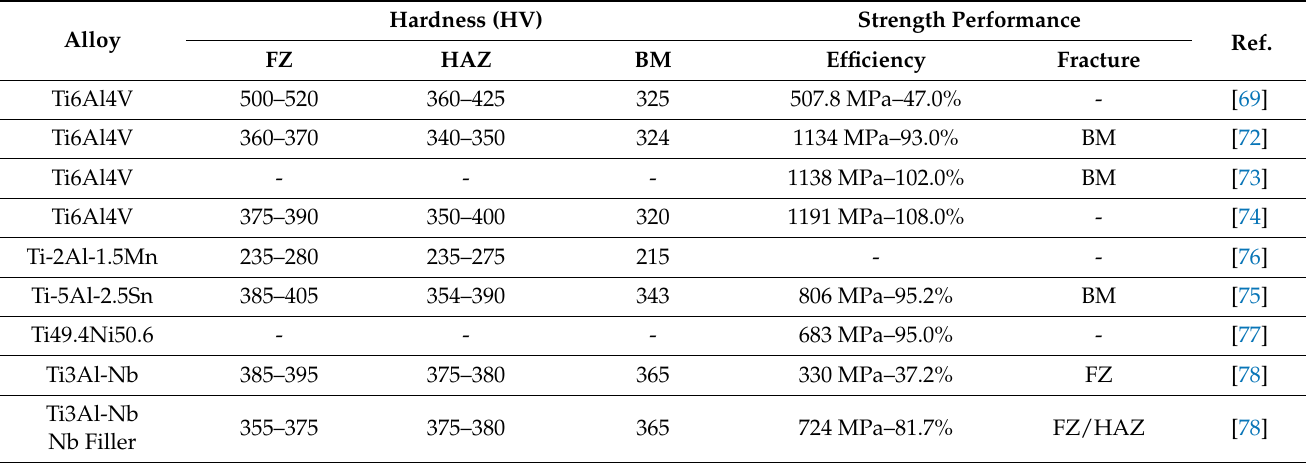
Figure 12. Pulsed laser weldments made of titanium: Ti-5Al-2.5Sn FZ ( A ) and HAZ ( B ) [75]; Ti-2Al-1.5Mn ( C ), its FZ ( D ) and HAZ ( E ) [76]; Ti49.4Ni50.6 TiNi ( F ), its FZ ( G ) and HAZ ( H ) [77]; Ti3Al-Nb ( I ) and Ti3Al-Nb with pure Nb filler metal ( J ) [78]. Table 3. Selected results of pulsed laser welding apply to similar titanium joints (approximated values).